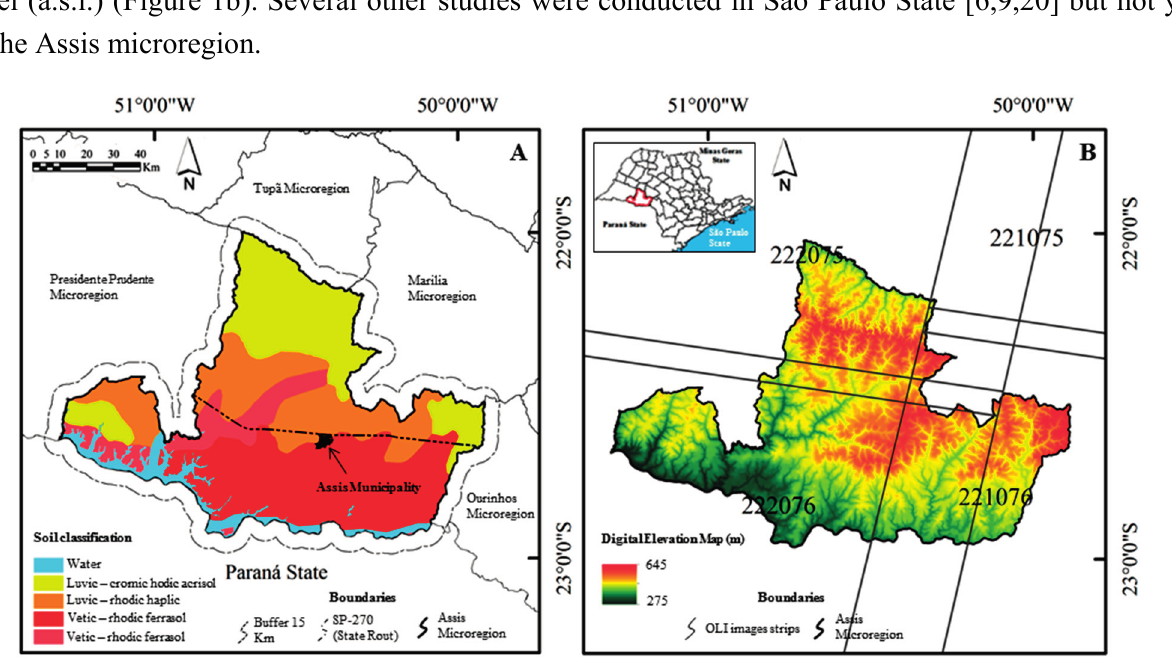
Figure 1. Soil types ( A ) and digital elevation model (DEM) ( B ) of the study area.